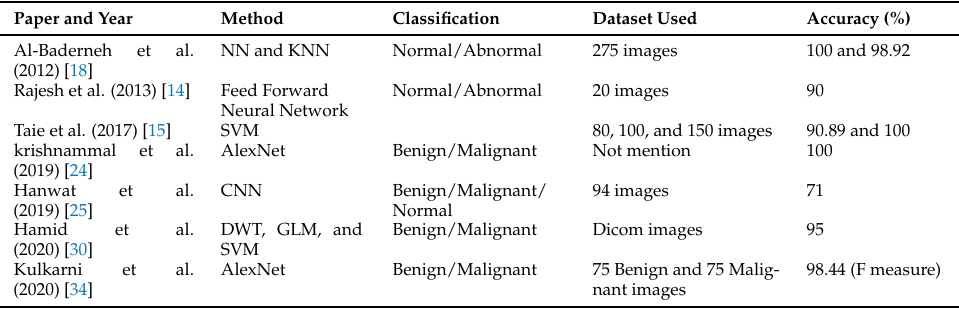
Table 1. Comparison of existing